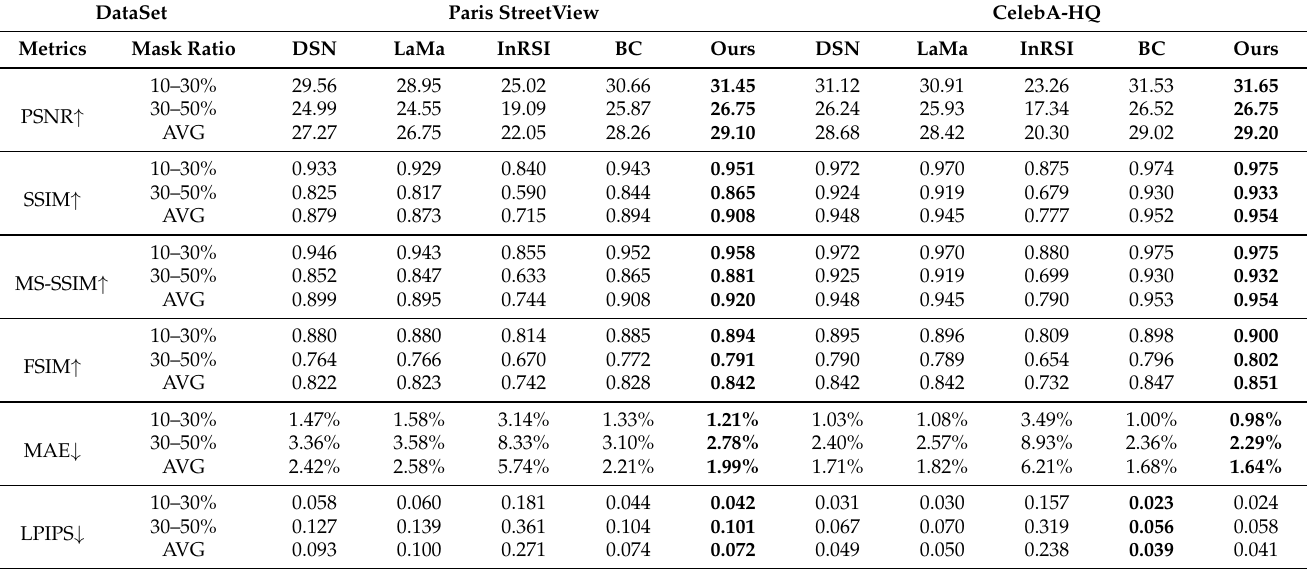
Table 5. Quantitative results with DSN [5], LaMa [44], InRSI [2], BC [43], and ours on Paris StreetView and CelebA-HQ